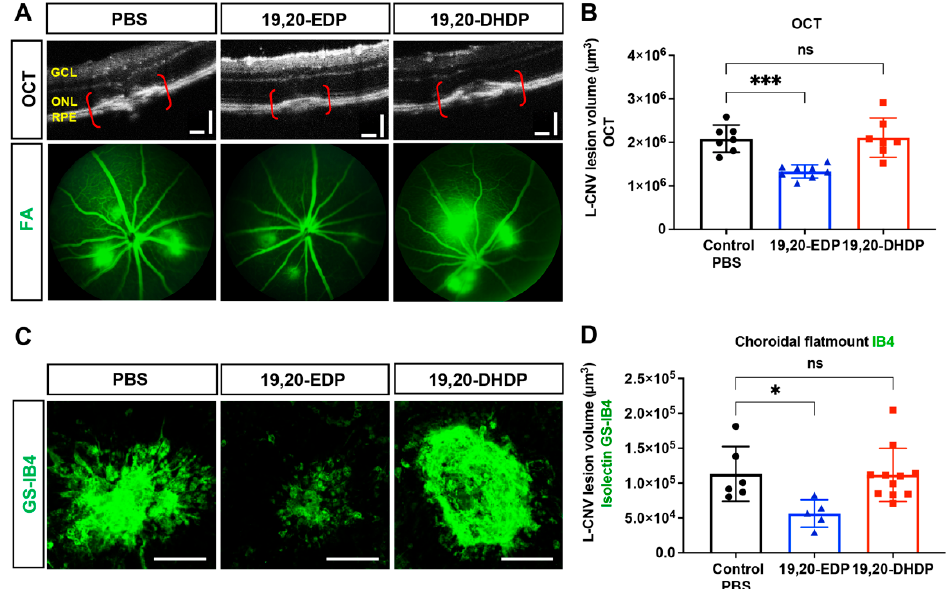
Figure 9. Lipid substrate of sEH, 19,20-EDP, is antiangiogenic when delivered intravitreally. A single intravitreal injection of 19,20-EDP at a final concentration of 100 μ M at the time of laser treatment reduces L-CNV lesion volume compared to vehicle (PBS + 0.5% DMSO). Intravitreal 19,20-DHDP (100 μ M) did not significantly change lesion volume. ( A ) Representative OCT and FA (green) fundus images on day 14 after laser. Scale bars = 100 μ m. ( B ) CNV lesion volume calculated as an ellipsoid from OCT images. ( C ) Representative images from confocal microscopy of Griffonia simplicifolia isolectin B4 (GS-IB4; green) stained CNV lesions. Scale bars = 100 μ m. ( D ) CNV lesion volume from Z-stack confocal images. Mean ± SEM, n = 5–11. Each data point represents an average of 2–3 L-CNV lesions per eye, one-way ANOVA with Dunnett’s post hoc test (ns, non-significant; * p < 0.05; *** p < 0.001).